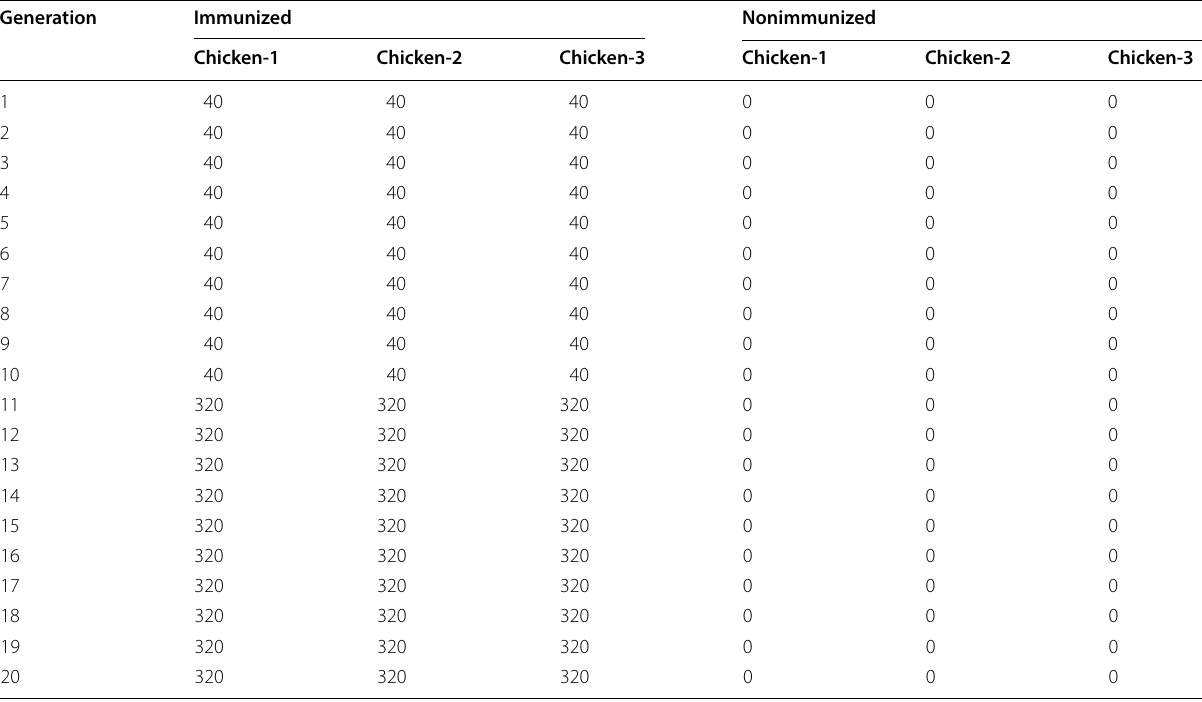
Table 2 Antibody titers in chicken sera in this study